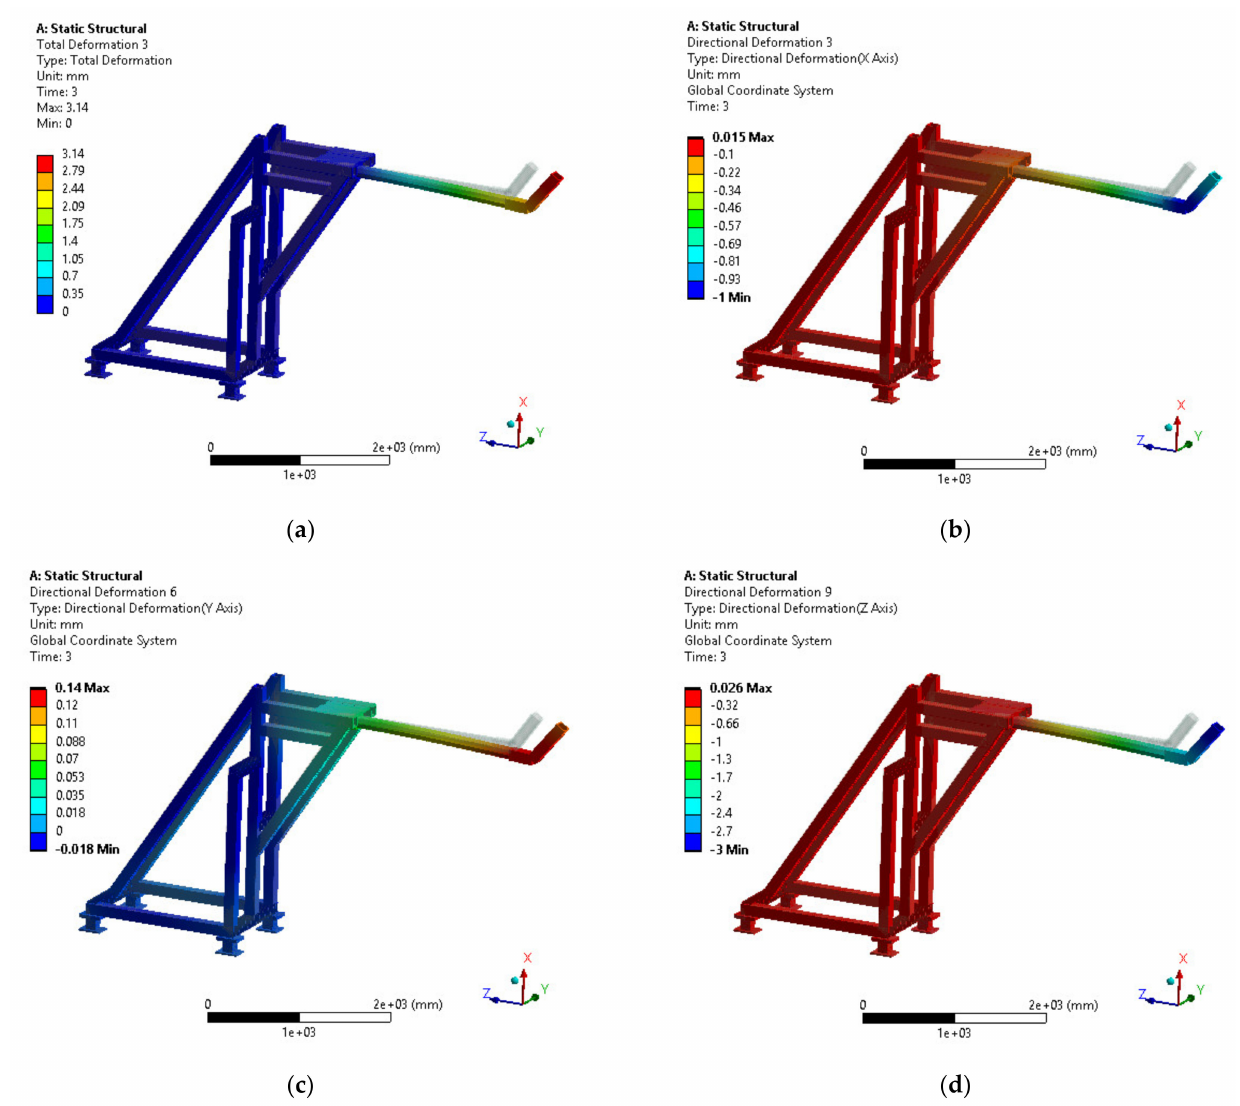
Figure 8. ( a ) Total deformation (mm); ( b ) directional deformation in the vertical axis (mm); ( c ) direc- tional deformation in the tangential vacuum vessel direction (mm); ( d ) directional deformation in the radial axis